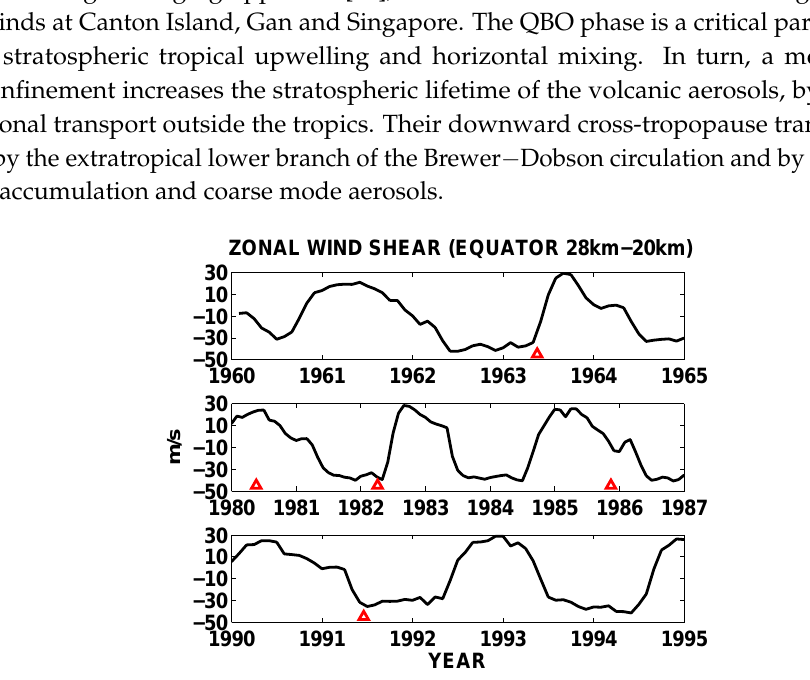
Figure 2. Time series of the observed equatorial zonal wind shear (28 km–20 km) with indication of the major volcanic eruptions considered in this study (red